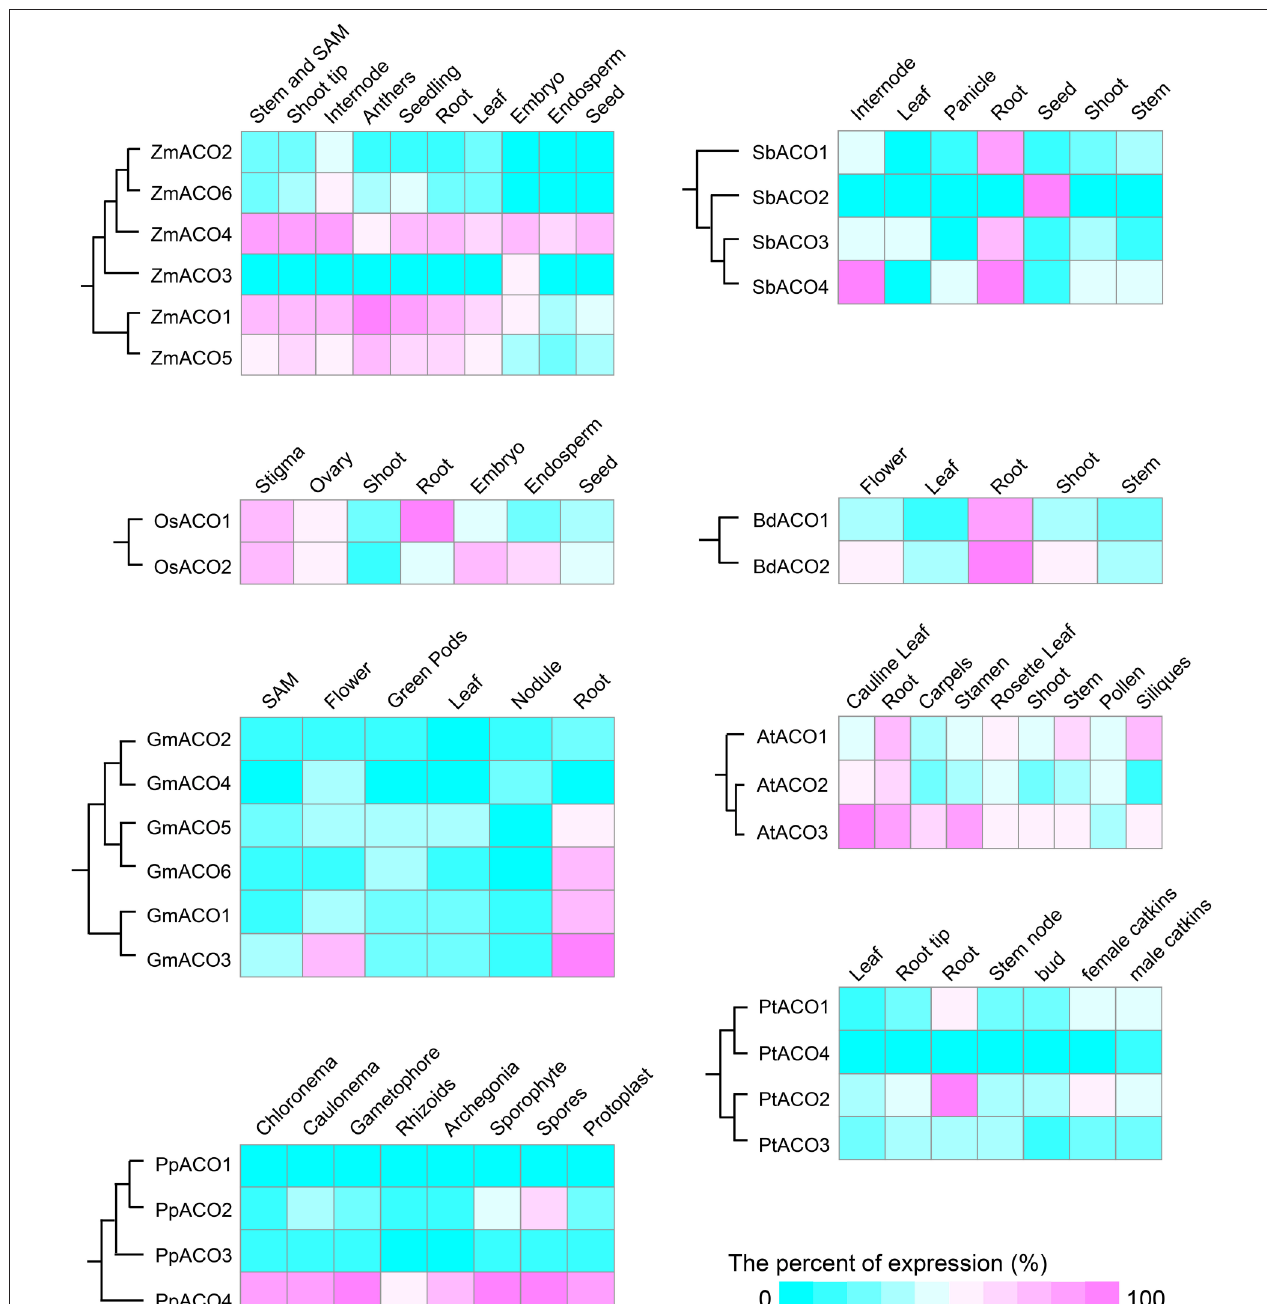
FIGURE 8 | The tissue-specific expression patterns of ACO genes. Expression profiles for Z. mays , S. bicolor , O. sativa , B. distachyon , G. max , A. thaliana , P. trichocarpa, and P. patens are shown. Color indicates normalized expression level (the relative percent of the highest expression in each species). SAM is the abbreviation of shoot apical